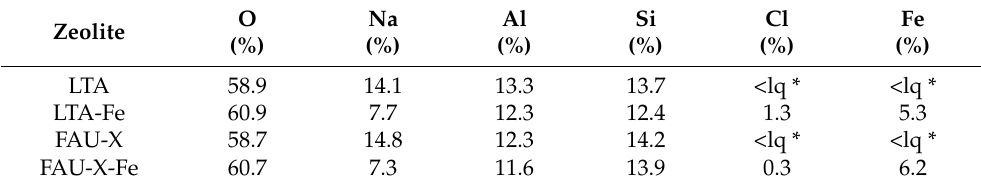
Table 2. Elemental composition of zeolites: LTA, LTA-Fe, FAU-X, and FAU-X-Fe. Zeolite